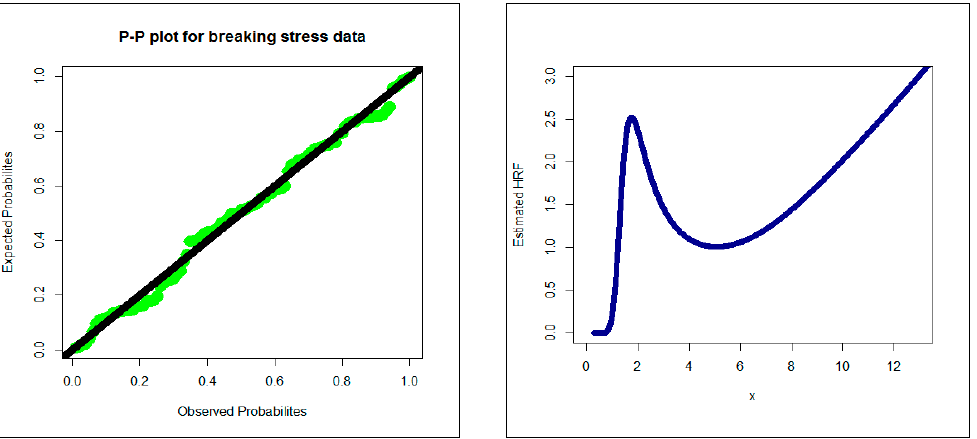
Figure 2. Estimated PDF (left right) and estimated CDF (right) for the breaking stress of carbon fibers data.